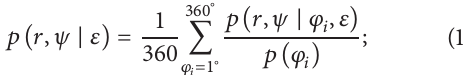
Figure 10: Illustration of intersection of a cone and an ellipsoid as a condition for the reflector location determination.